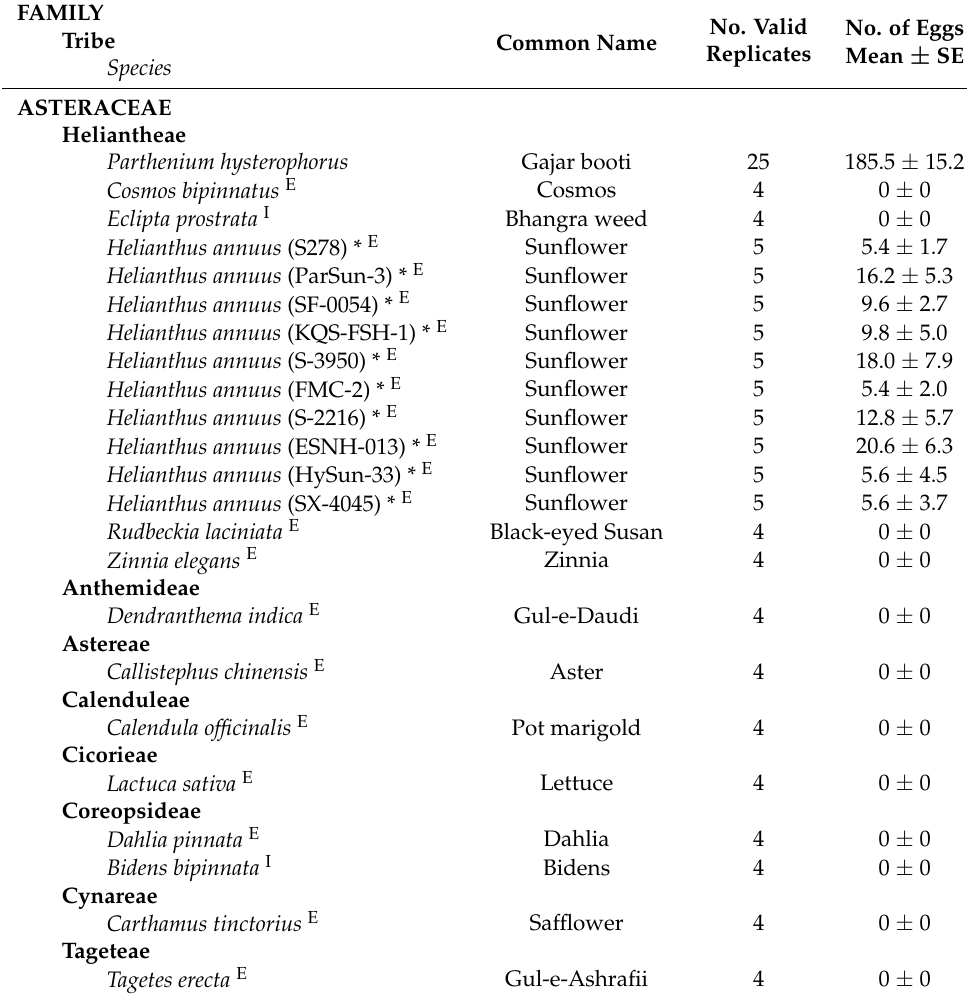
Table 1. The no-choice oviposition tests with Listronotus setosipennis against indigenous and economi- cally important Asteraceae plant species in Pakistan between 2019 and